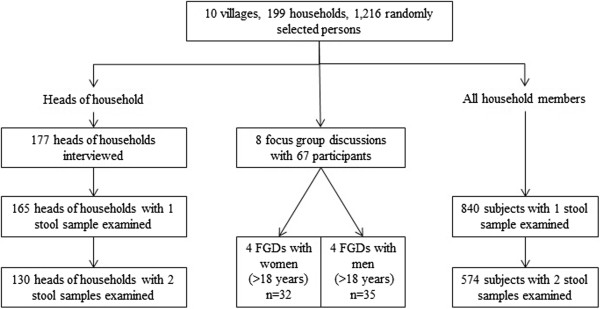
Study diagram, Saravane district, 2010.